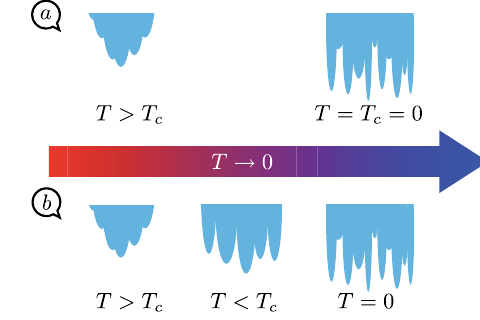
FIG. 5. Sketch of the (coarse-grained) energy landscape for a system with a zero-temperature transition [panel (a), top] and a finite-temperature transition [panel (b), bottom] to a spin-glass state. For high enough temperatures, i.e., above the critical FIG. 4. The disorder p vs temperature T ¼ T m phase diagram c temperature T , the energy landscape is simple, with one clear c for the random-bond Ising model defined on the Chimera graph. minimum that dominates and some “ bumps along the way. ” For a The (blue) dotted line represents the Nishimori line. The red system that has a finite-temperature transition and for temper- (solid) line is a guide to the eye. Under the solid curve, the atures T < T , the energy landscape becomes rough, with clear c ≈ 0 . 1985 ð 15 Þ , system orders ferromagnetically (FM). For p ≥ p c barriers that render any classical annealing schedule inefficient ferromagnetic order is lost and the system is paramagnetic (PM). because the system can easily be trapped in a metastable state for For p ≳ p and T ¼ 0 , there is a zero-temperature spin-glass c decreasing temperature. These barriers grow with increasing state [37]. system size N and decreasing temperature T until they form a rough energy landscape for T ¼ 0 (ground state of the system). 0 , such as spin glasses on the Chimera For a system where T c ¼ topology, the energy landscape is typically simpler up until the ground state is reached. This means that for such a system, a classical annealing schedule like simulated annealing should perform better in comparison to quantum annealing, which excels when the energy landscape exhibits barriers